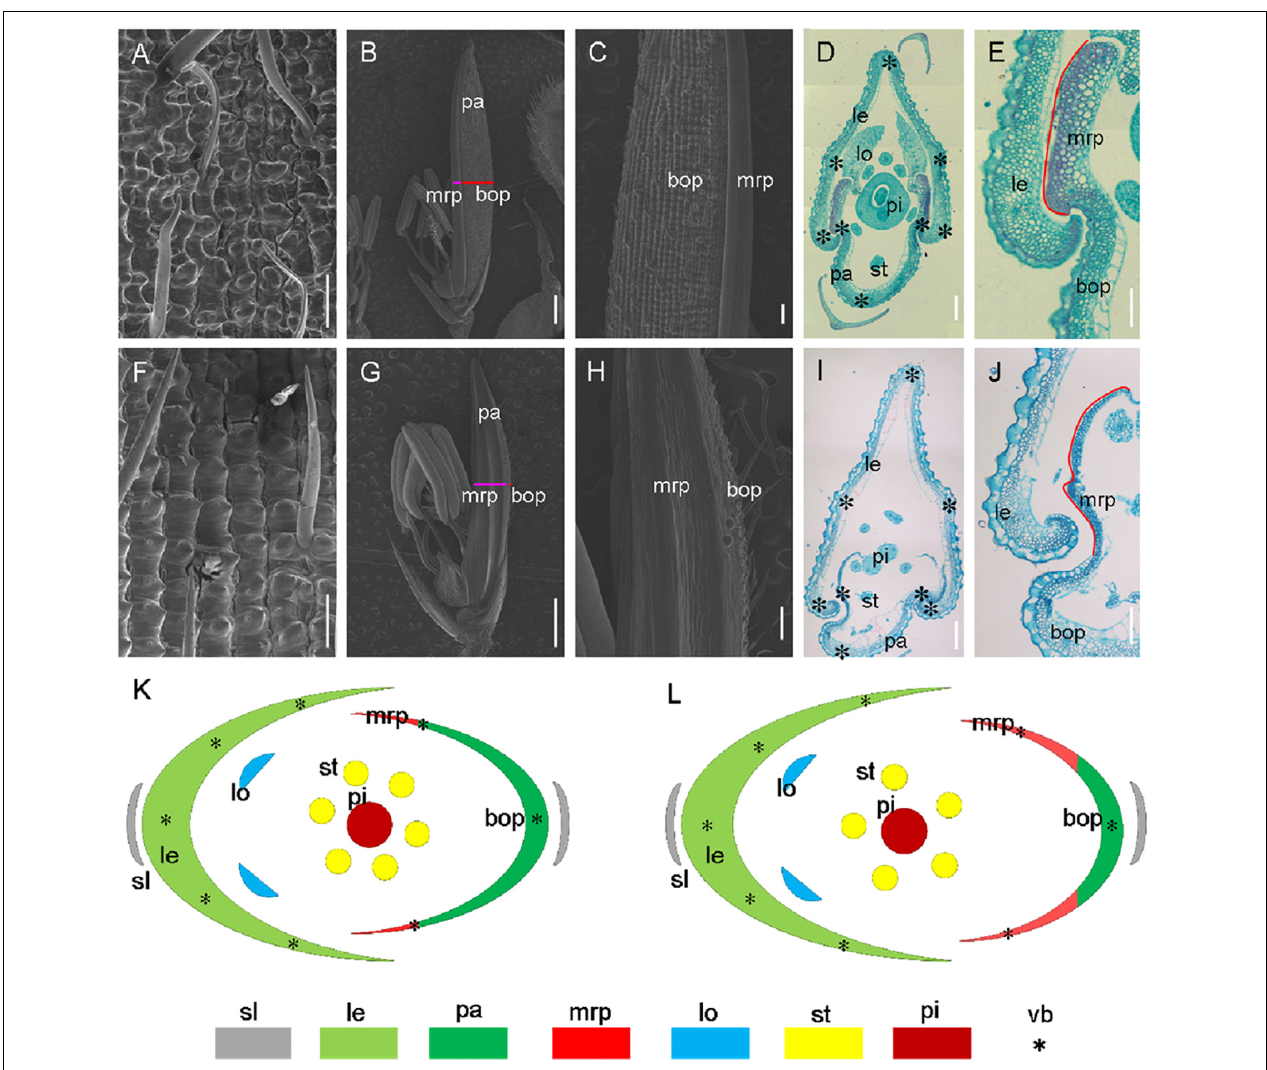
FIGURE 2 | Histological analysis of hull in the wild-type and the mr1 mutant. (A) Epiderm of the wild-type lemma. (B) Epiderm of the wild-type palea. (C) Enlarged palea in the wild-type. (D) Transverse section of wild-type floret. (E) Interlocked structure of wild-type hull. (F) Epiderm of the mr1 lemma. (G) Epiderm of the mr1 palea. (H) Enlarged palea in the mr1 mutant. (I) Transverse section of mr1 floret. (J) Interlocked structure of mr1 hull. (K) Diagram of wild-type spikelet. (L) Diagram of mr1 spikelet. le, lemma; pa, palea; lo, lodicule; st, stamen; pi, pistil; bop, body of palea; mrp, marginal region of palea; sl, sterile lemma; vb, vascular bundle. Black asterisks indicate the vascular bundles. Red lines indicate the mrp. Bars, 100 µ m in (A,E,F,J) ; 1 mm in (B,G) ; 200 µ m in (C,D,H,I)